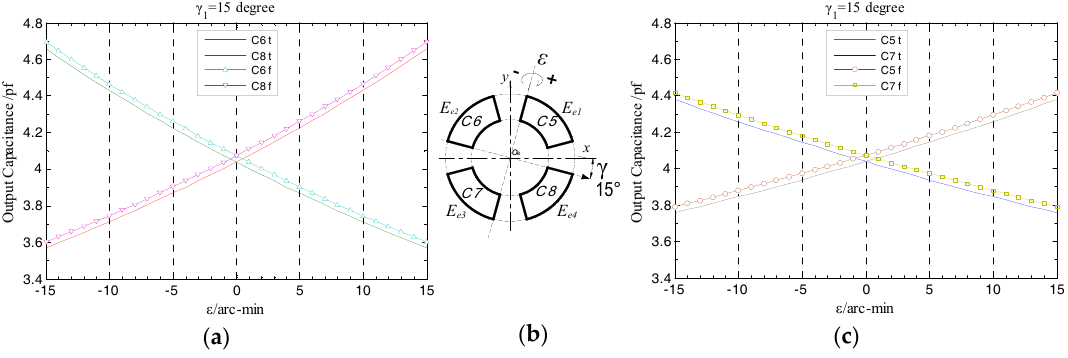
Figure 15. Simulation and theoretical results comparison for the output capacitance of the end part fan-shaped electrodes: ( a ) The 2nd, 4th quadrant; ( b ) tilt schematic; ( c ) the 1st, 3rd quadrant.